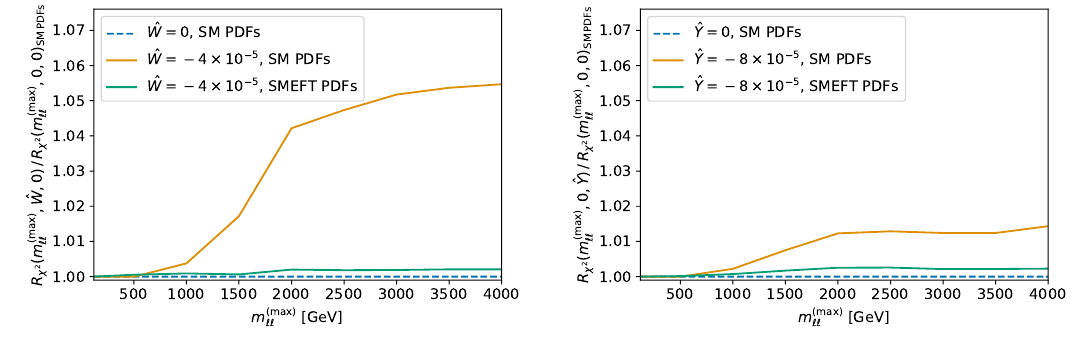
Figure 17 . Same as figure 7 now for the fits including the HL-LHC pseudo-data. Note that in this case the m (max) cut refers to the transverse mass m T for the charged-current ‘‘